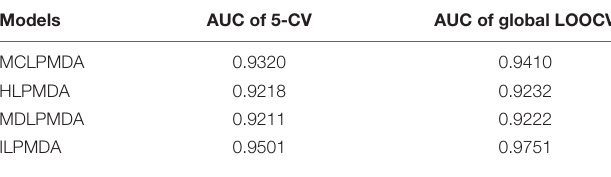
TABLE 1 | Comparisons between ILPMDA and LP-based models.